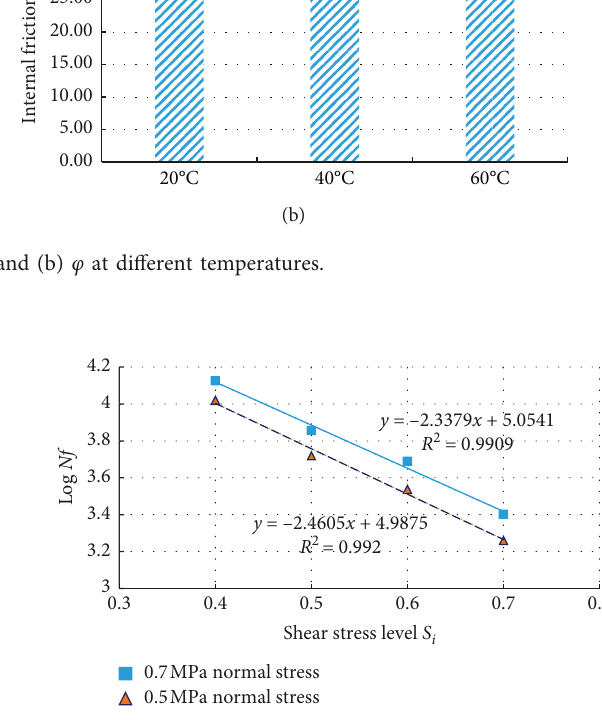
f ) curve of the AC-13 shear fatigue